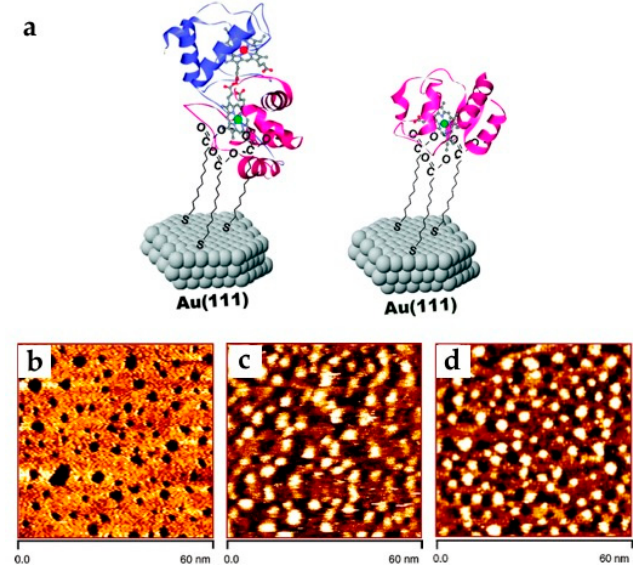
Figure 3. ( a ) Schematic illustration of P. stutzeri cyt c 4 (left) and horse heart cyt c (right) on SAM-modified Au(111); in situ STM images of a ω -mercapto-decanoic acid SAM-modified Au(111)-electrode surface ( b ) without protein as a reference, ( c ) with the two-domain P. stutzeri cyt c 4 vertically oriented (sharp roughly circular spots), and ( d ) horse heart cyt c (sharp roughly circular spots) in 5 mM pH 7.0 phosphate buffer under potential control in constant current mode; scan area, 60 × 60 nm 2 Reproduced with permission from [64]. Copyright 2010, American Chemical Society.